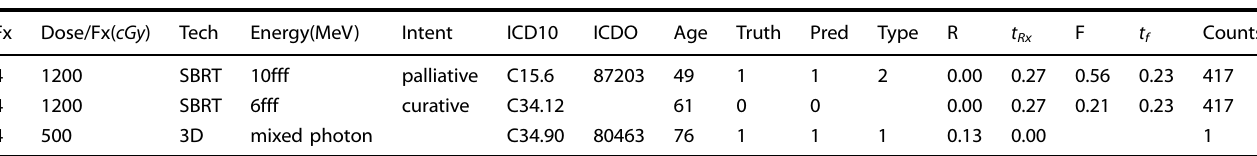
Table 2. Prediction